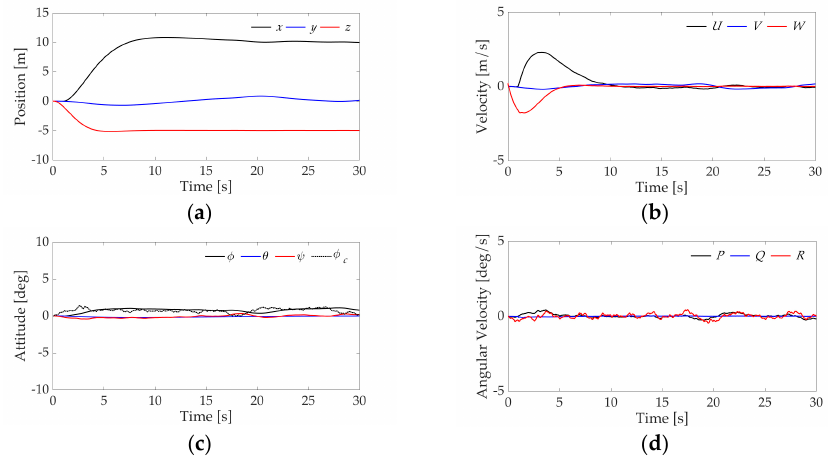
Figure 12. Time responses of state variables using proposed controller. ( a ) Position; ( b ) Velocity; ( c ) Attitude; ( d ) Angular velocity.